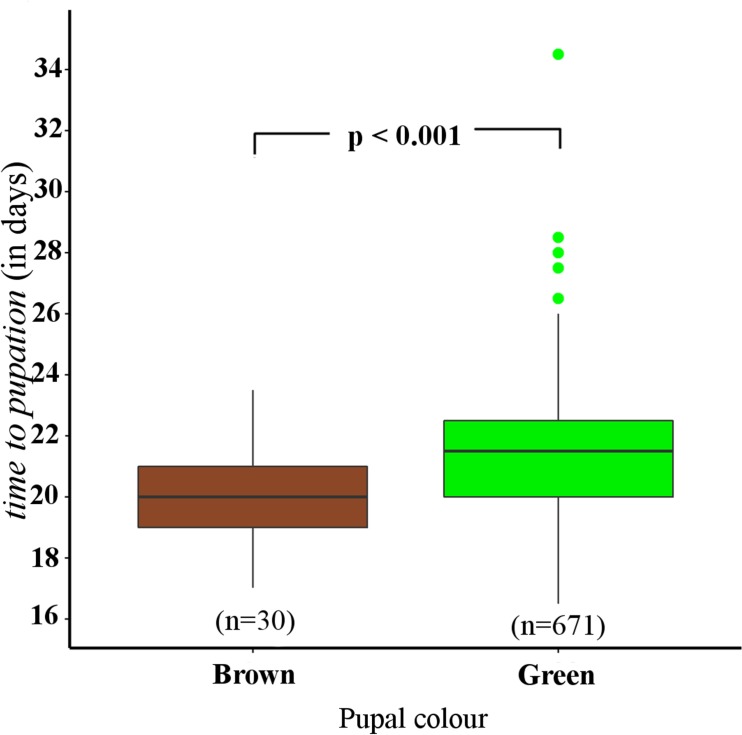
Box-plots representing the effect of time to pupation on pupal colour.Lines in the centre of the box represent the median. Limits of the box are marked by 25th and 75th percentiles. Whiskers are 1.5 times the interquartile range from the 25th and 75th percentiles. Dots represent outliers.